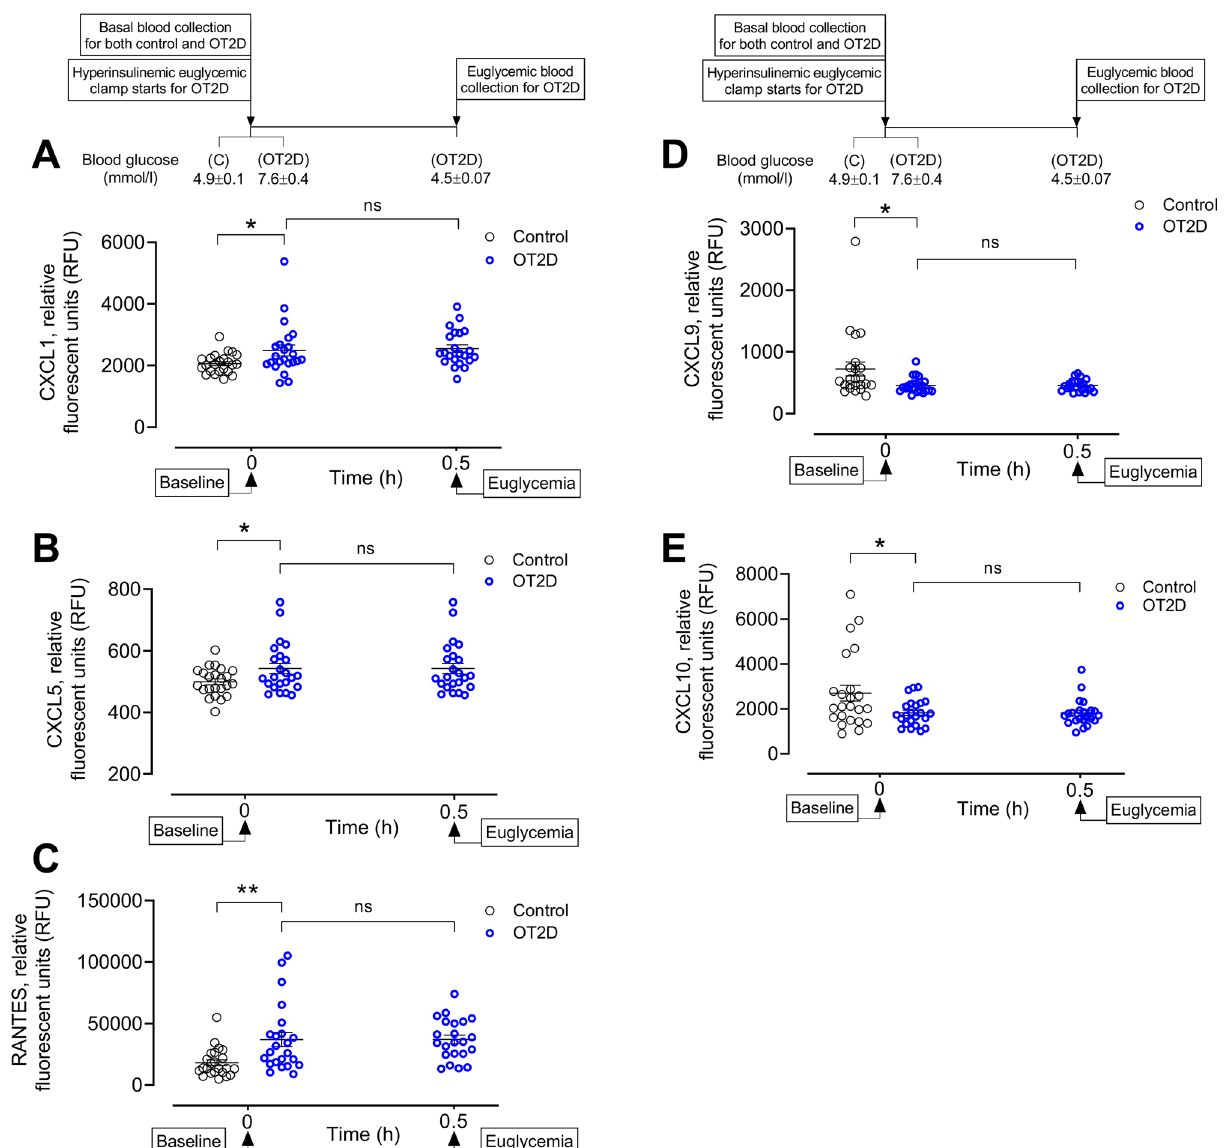
Figure 2. Circulatory levels of cytokines and chemokines released from activated M1 macrophages in the steady state of obese type 2 diabetes (OT2D). Plasma CXCL1 ( A ), CXCL5 ( B ), CCL5 (RANTES) ( C ), CXCL9 ( D ) and CXCL10 ( E ) levels in control subjects (black circles) and obese subjects with T2D (blue circles). Basal level of plasma CXCL1, CXCL5 and RANTES was higher in OT2D compared to control (2487 ± 177 vs 2060 ± 67 RFU of CXCL1, OT2D vs control, p < 0.05; 543 ± 17 vs 500 ± 10 RFU of CXCL5, OT2D vs control, p < 0.05; 36,961 ± 5692 vs 18,162 ± 2393 RFU of RANTES, OT2D vs control, p < 0.01). Basal levels of plasma CXCL9 and CXCL10 were lower in T2D compared to control (455 ± 26 vs 722 ± 113 RFU of CXCL9, and 1825 ± 122 vs 2706 ± 352 RFU of CXCL10, OT2D vs control, p < 0.05). Acute normalization of glycemia had no effect on levels of CXCL1. CXCL5, RANTES, CXCL9 and CXCL10 in T2D subjects (A-E). Data were presented as mean ± SEM. *, p < 0.05, **, p <